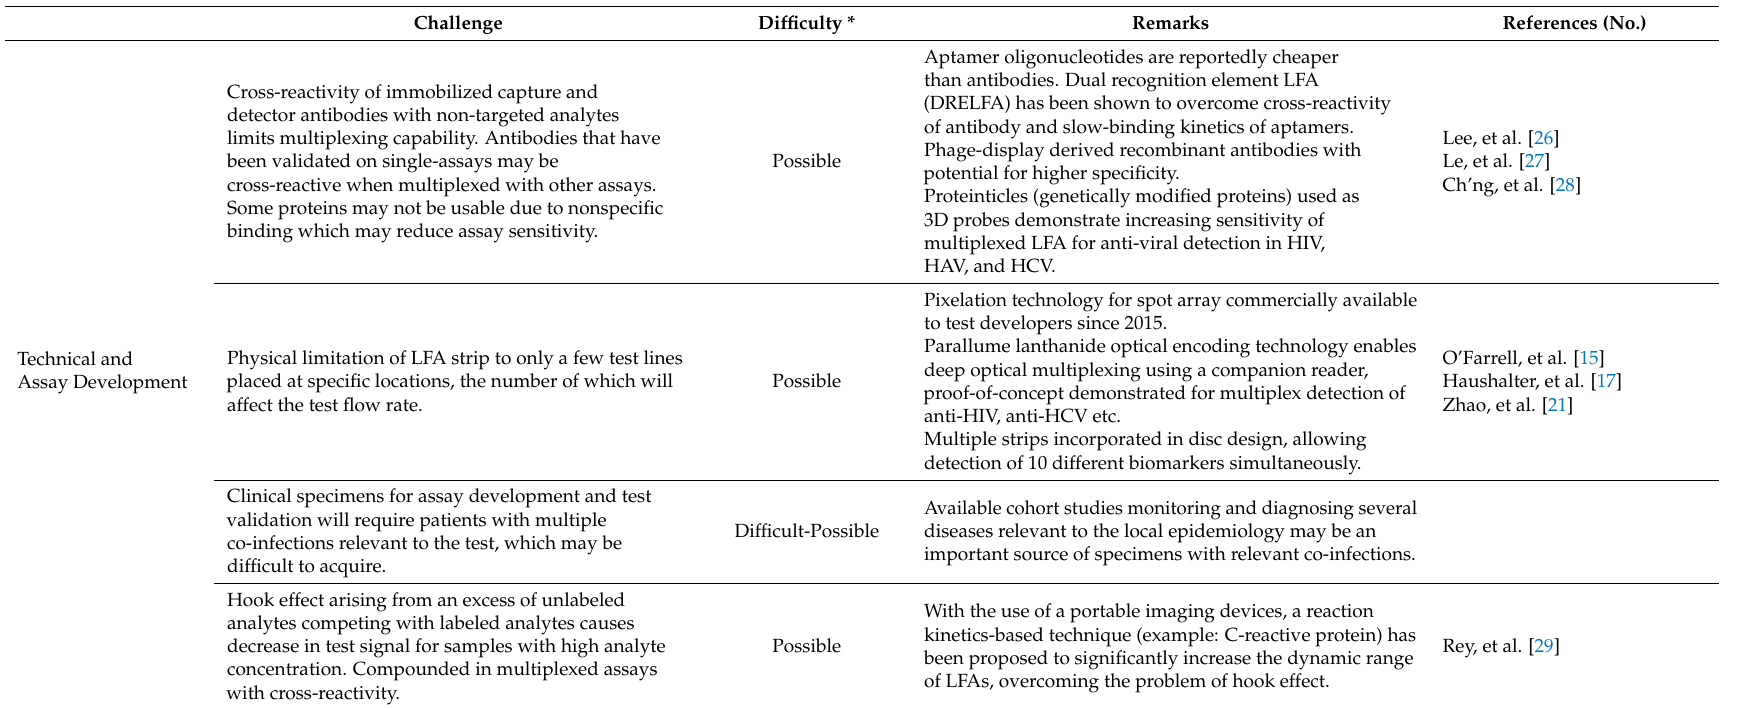
Table 1. Assessment of challenges in multiplexing lateral flow assays